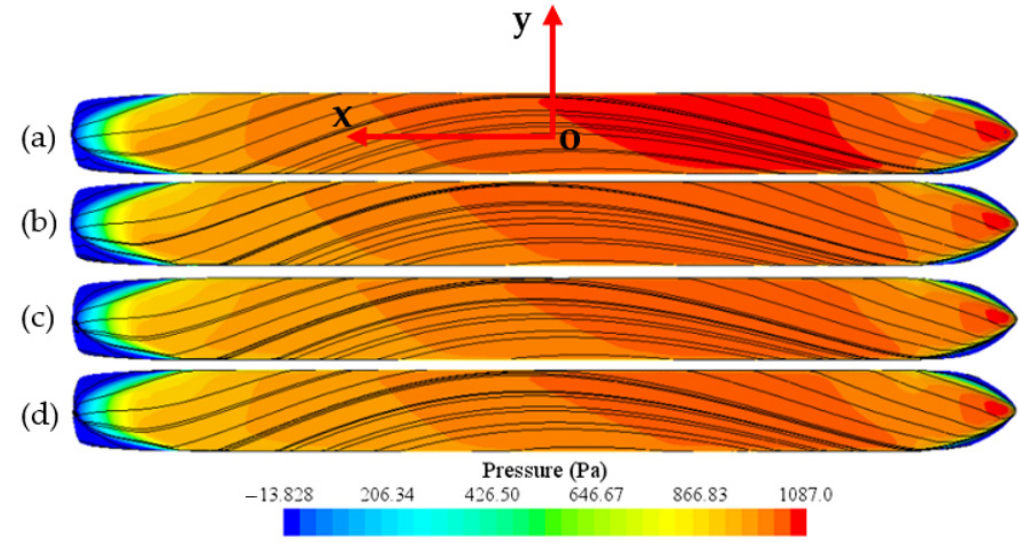
Figure 13. Pressure contours with streamlines of slope angle variation. ( a – d ): slope angle is 13°, 27°, 50°, 90°, respectively